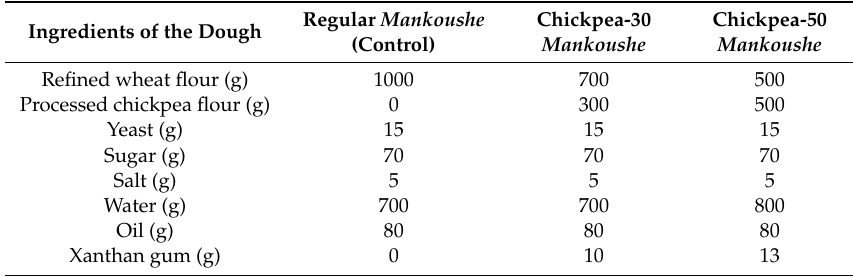
Table 1. Formulation of regular, chickpea-30 and chickpea-50 mankoushes